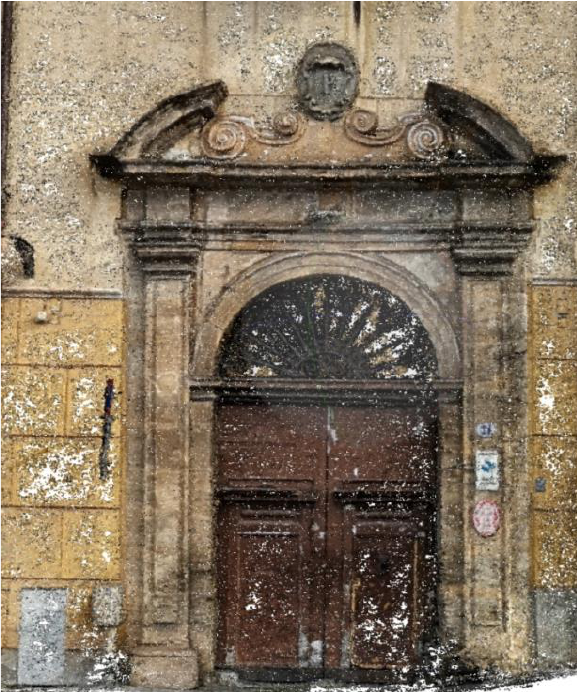
Figure 11: SfM reconstruction using Super- resolution image of the portal of the façade of the ancient building. Dense Cloud.